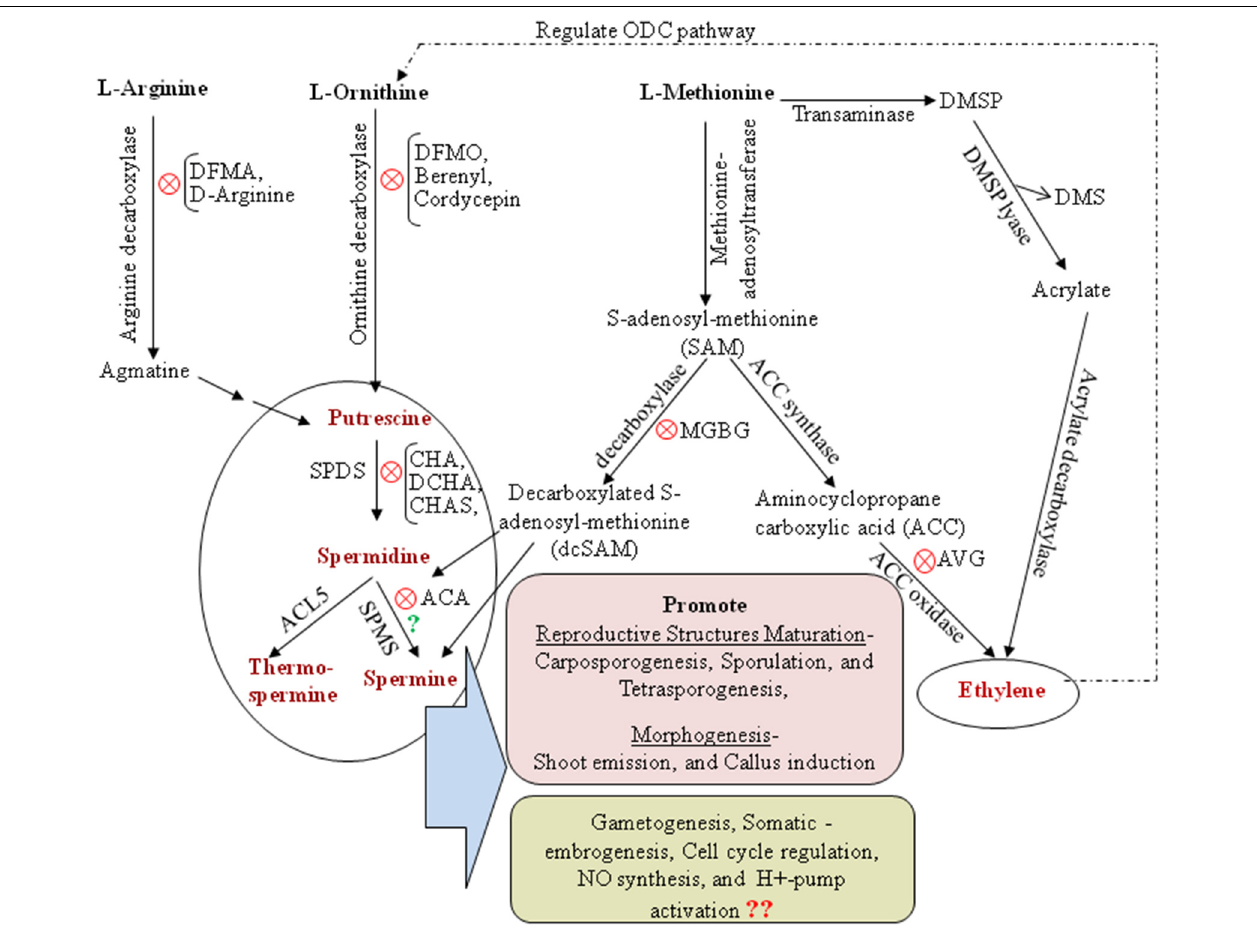
FIGURE 1 | Polyamine and ethylene biosynthetic pathway with special reference to seaweeds. ODC, ornithine decarboxylase; DFMA, difluoromethylarginine; DFMO, difluoromethylornithine; DMSP, Dimethylsufoniopropionate; CHA, cyclohexylamine; CHAS, cyclohexylammonium sulfate; DCHA, dicyclohexylamine; ACA,